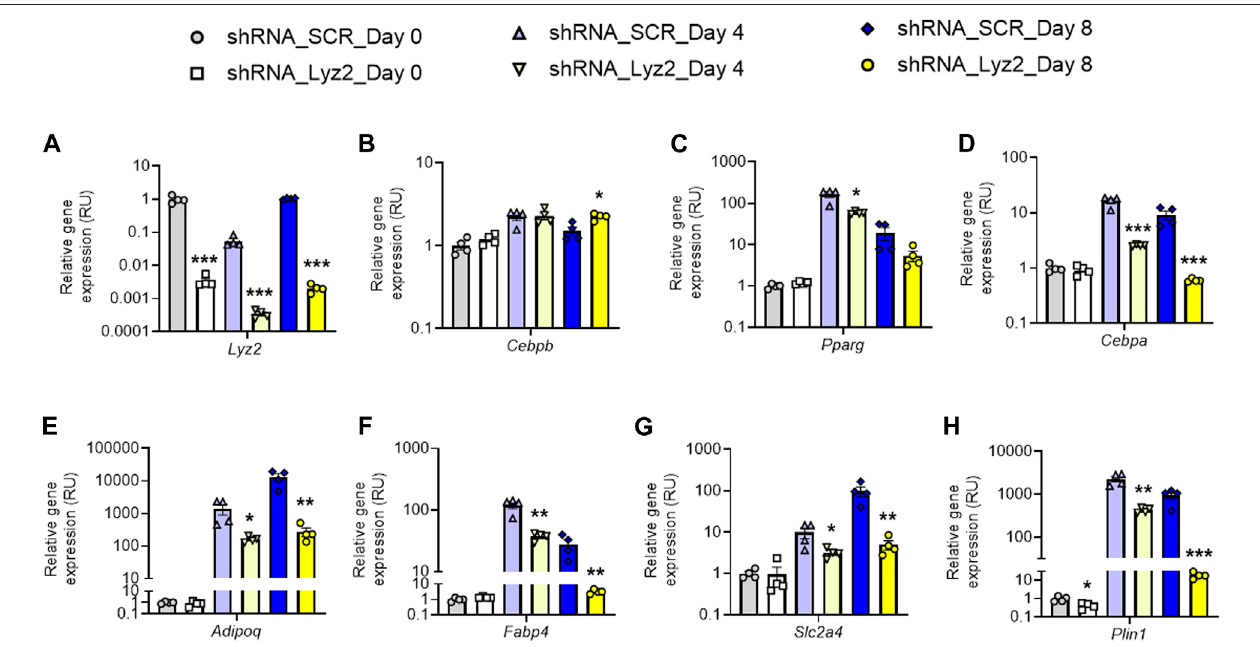
FIGURE 2 | The impact of Lyz2 gene knockdown on expression of adipogenic genes during 3T3-L1 adipocyte differentiation. (A – H) Lyz2, Cebpb, Pparg, Cebpa, Adipoq, Plin1, Slc2a4 and Fabp4 gene expression during 3T3-L1 adipocyte differentiation at day 0, 4 and 8. * p < 0.05, ** p < 0.01 and *** p < 0.001 compared to shRNA_SCR.